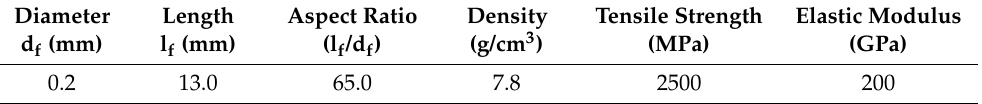
Table 3. Steel fiber